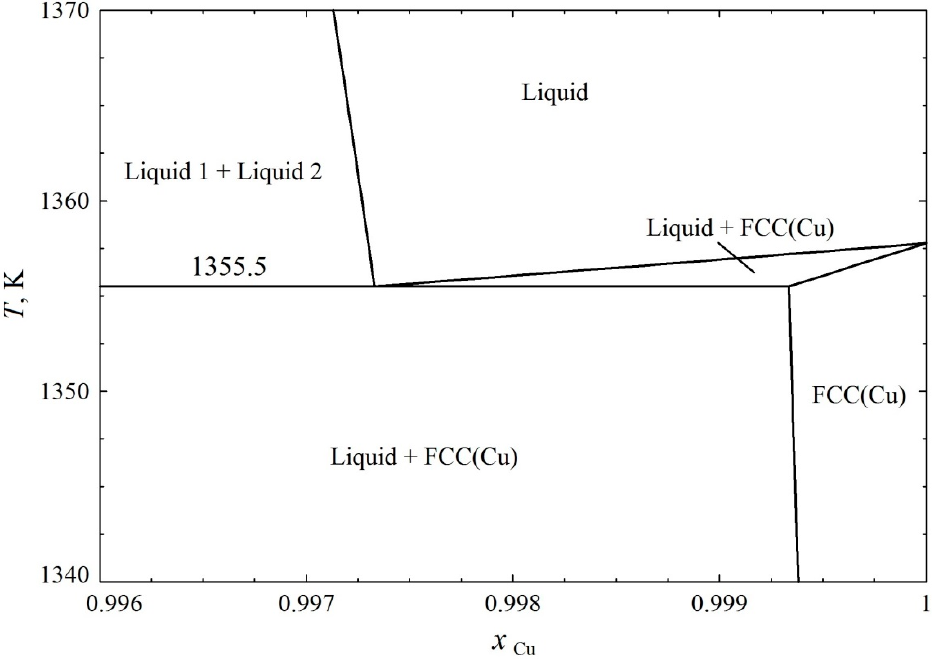
Figure 4. Calculated phase diagram of the Na-Cu system. Zoom for the area with low sodium concentration.